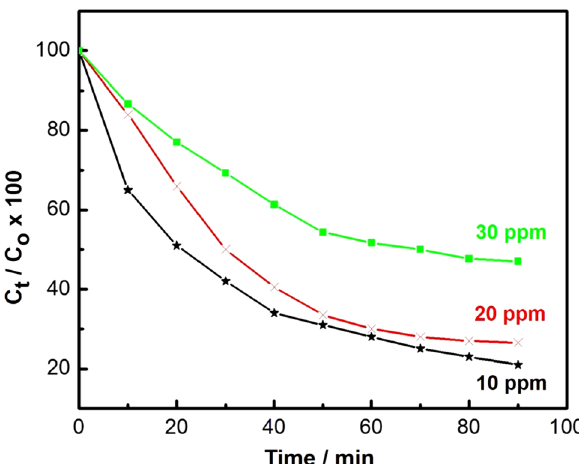
Figure 9. Effect of initial concentration of chloramine-T on the degradation efficiency (10 mg of nanocomposite, 50 ml chloramine-T solution, Temp. = 25 °C and pH = 7).